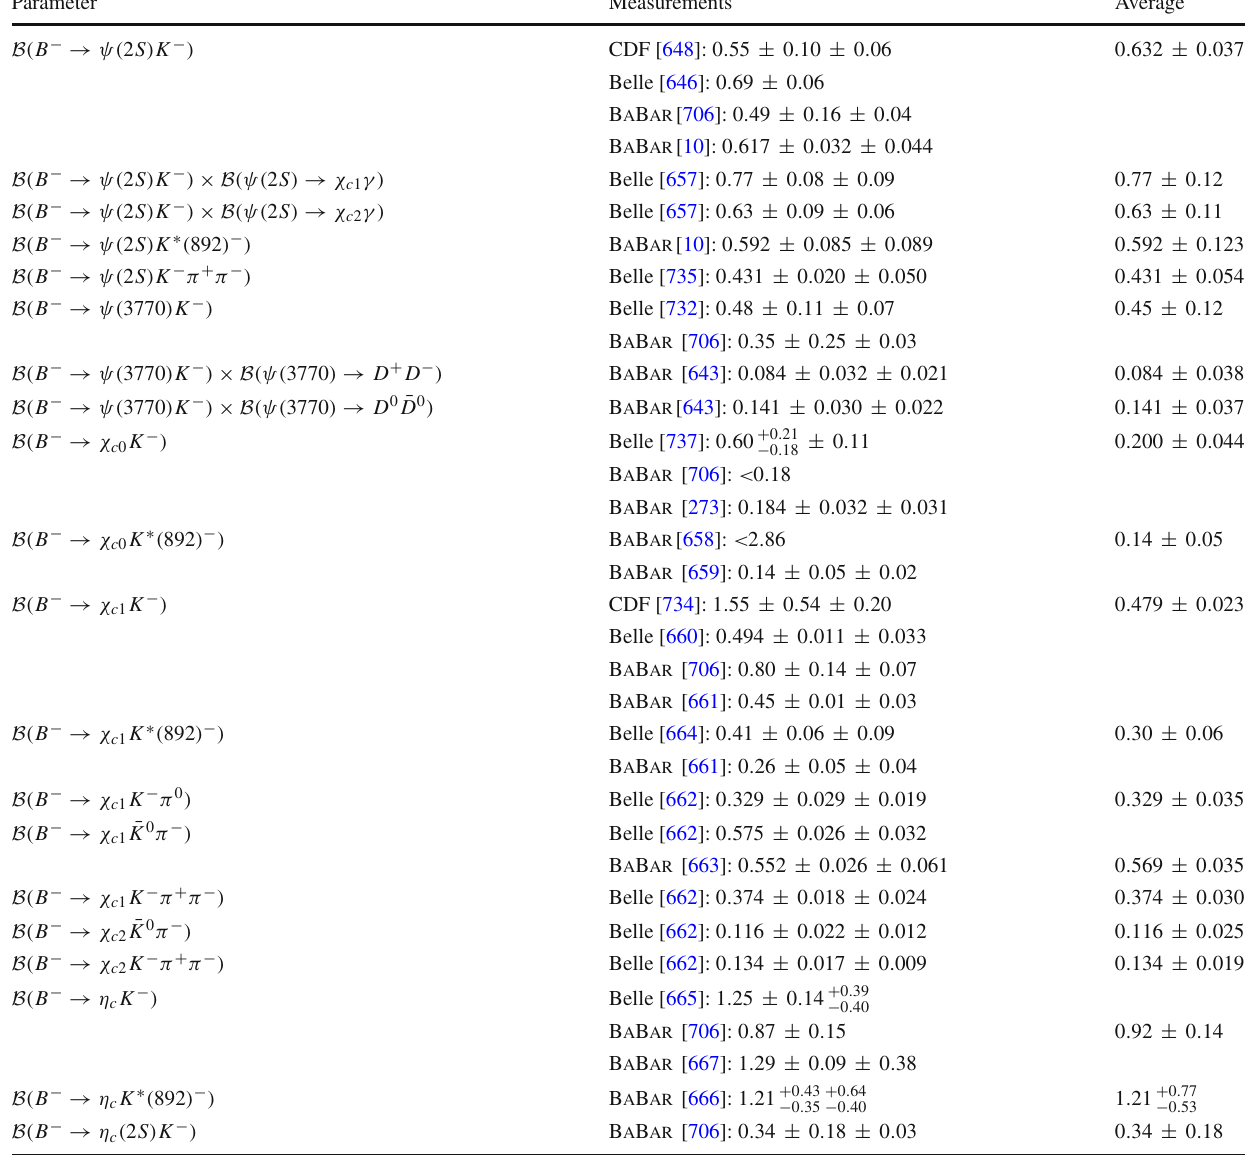
Table 161 Decays to charmonium other than J /ψ and one kaon I [ 10 − 3 ] Parameter Measurements Average